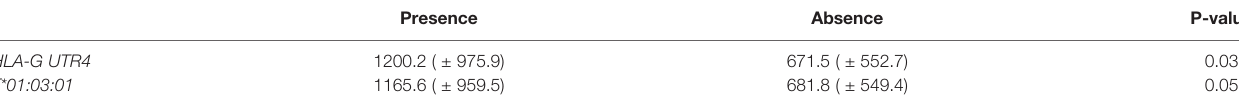
TABLE 4 | IgG4 expression (Mean ( ± SD), IU/mL) according to HLA Ib genetic polymorphisms (Wilcoxon-Mann-Whitney